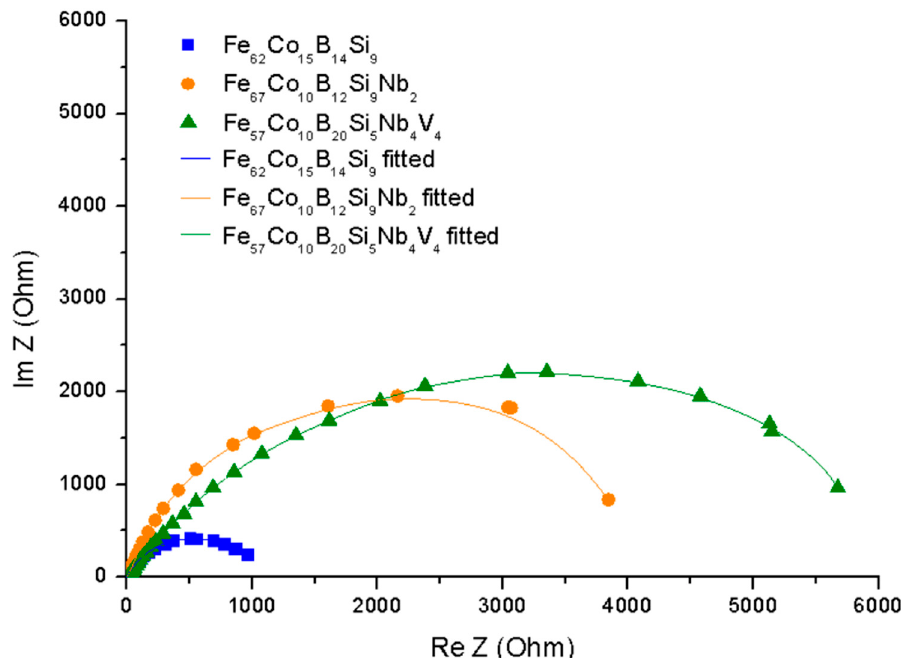
Figure 7. EIS for specimens in 0.5 M NaCl—Nyquist plots.